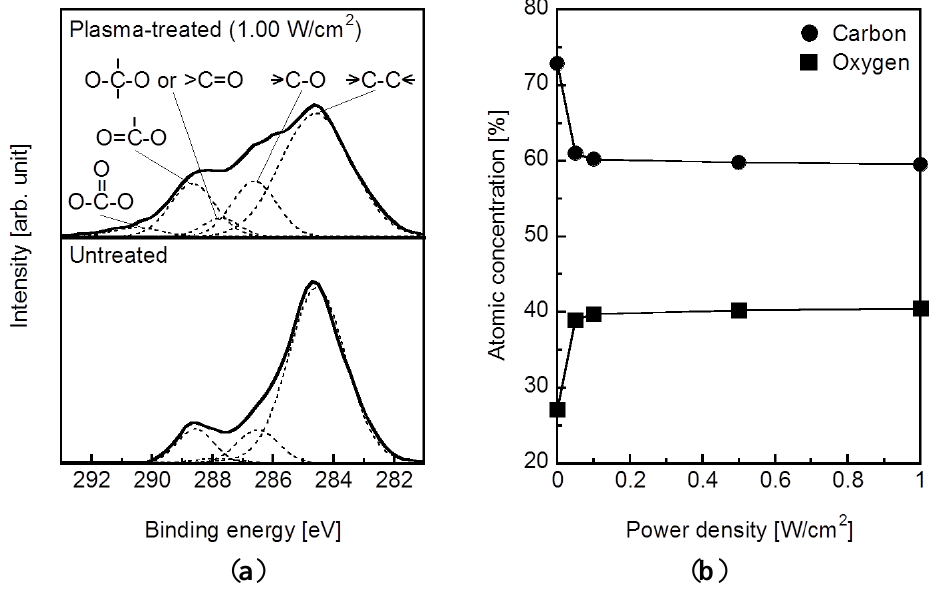
Figure 1. ( a ) C XPS spectra and ( b ) the surface atomic concentrations of C and O on 1S plasma-treated (0.05‒1.00 W/cm 2 ) and untreated plate